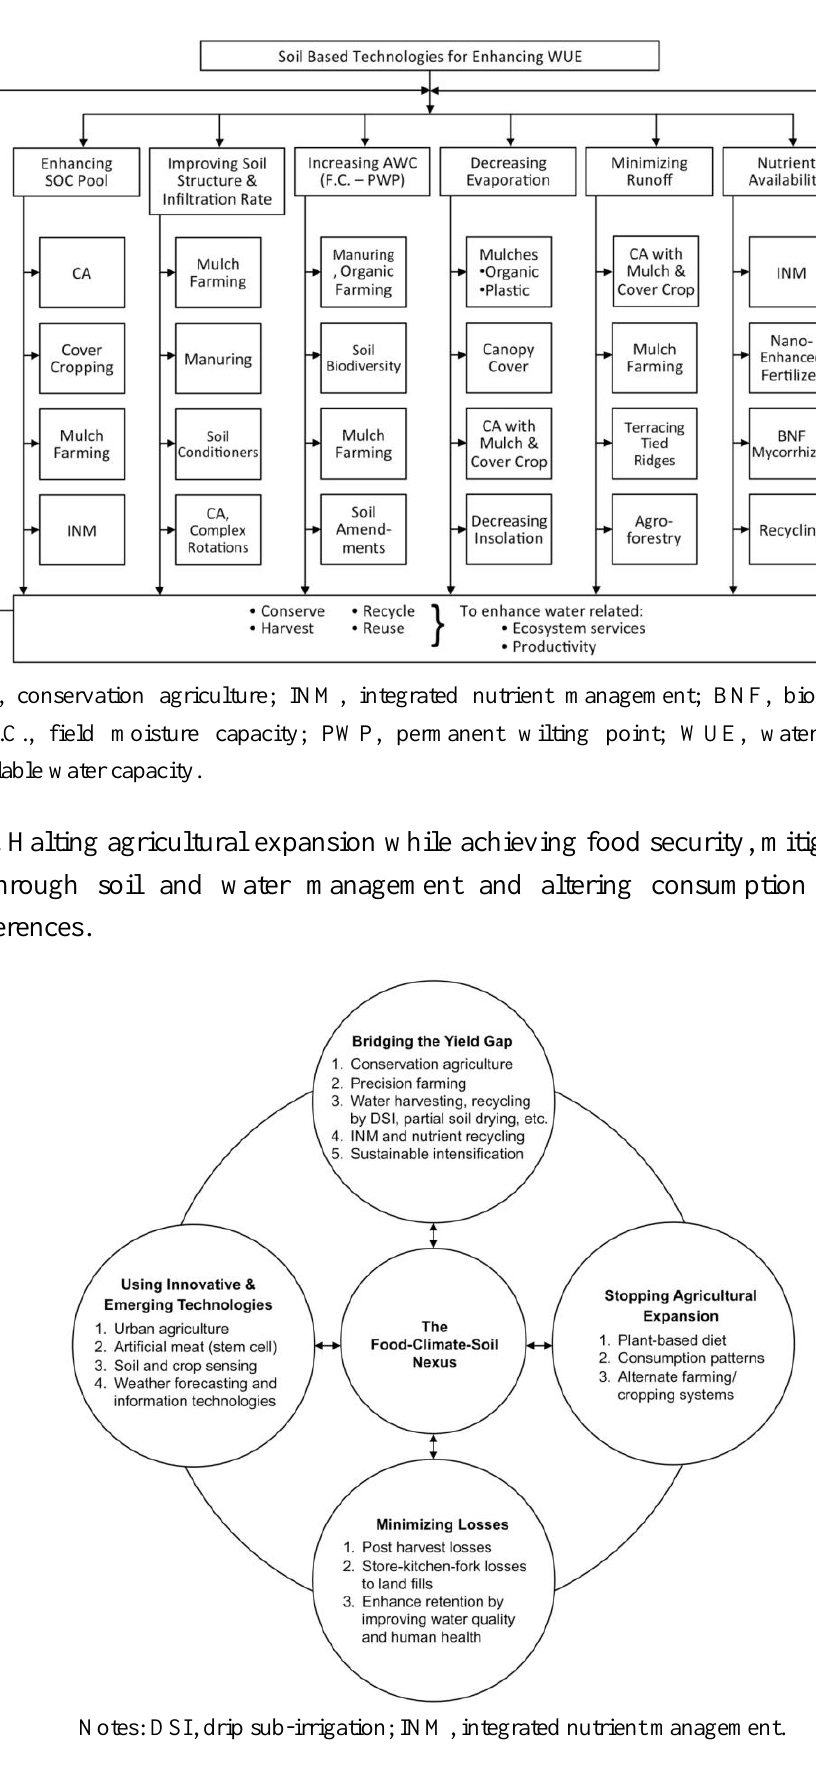
Figure 4. Principles and practices of enhancing the water use efficiency.